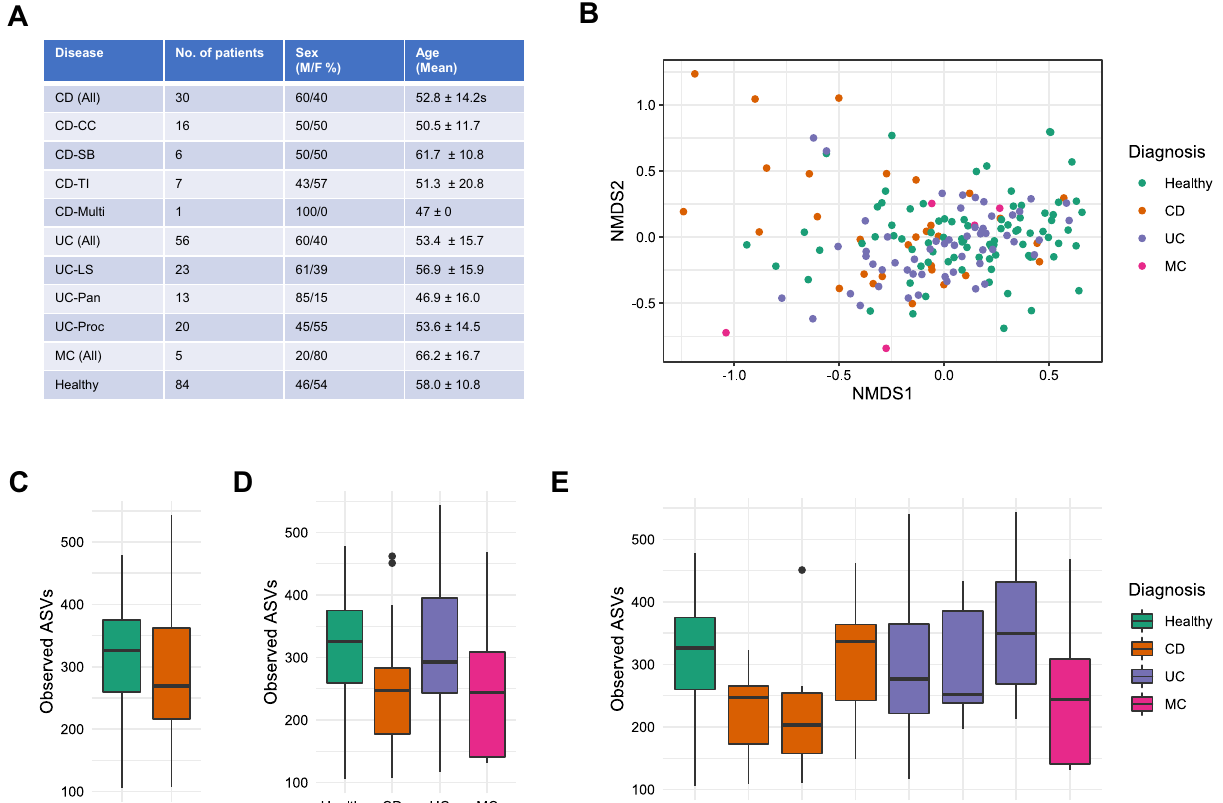
Figure 1. ( A ) Overview of FAMISHED Patient cohort. ( B ) NMDS ordination plot based on the Bray Curtis dissimilarity between Healthy Controls and three IBD conditions, CD, MC, UC. ( C ) The Observed ASV diversity of Healthy Controls and patients classified as having IBD. ( D ) The Observed ASV diversity of Healthy Controls and patients classified as having CD, UC, and MC. ( E ) The Observed ASV diversity of Healthy Controls and patients classified as having CD, UC, and MC when accounting for disease location in CD and UC